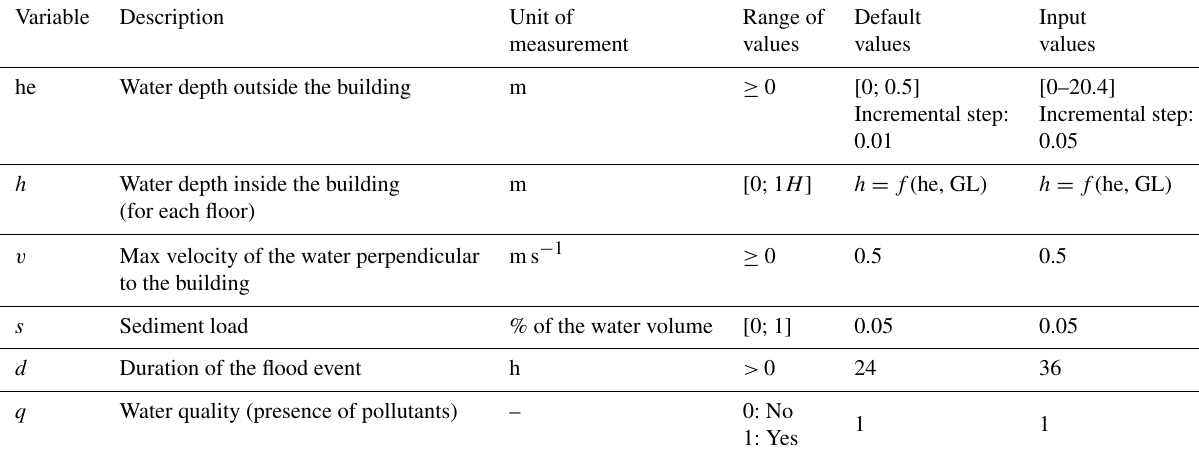
Table B1. Feature parameters from the INSYDE model input data.